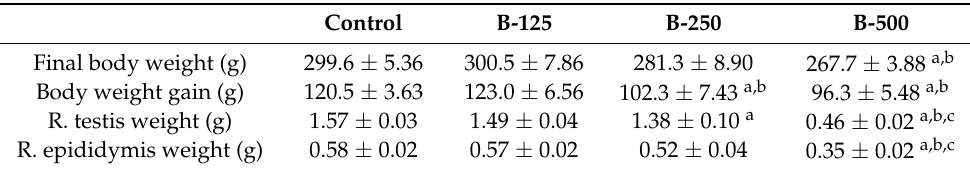
Table 4 . Control and rats treated with boric acid at different dose levels (125, 250, and 500 mg/kg of body weight), modified from [110] .